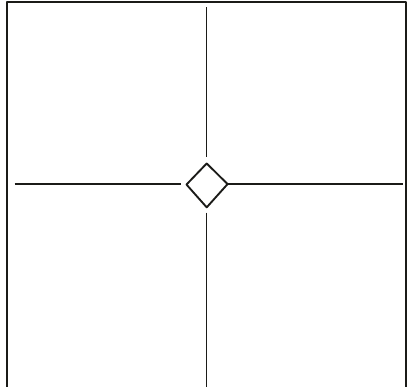
Figure 2: Schematic representation of the different quadrants evaluated around each Vickers impression